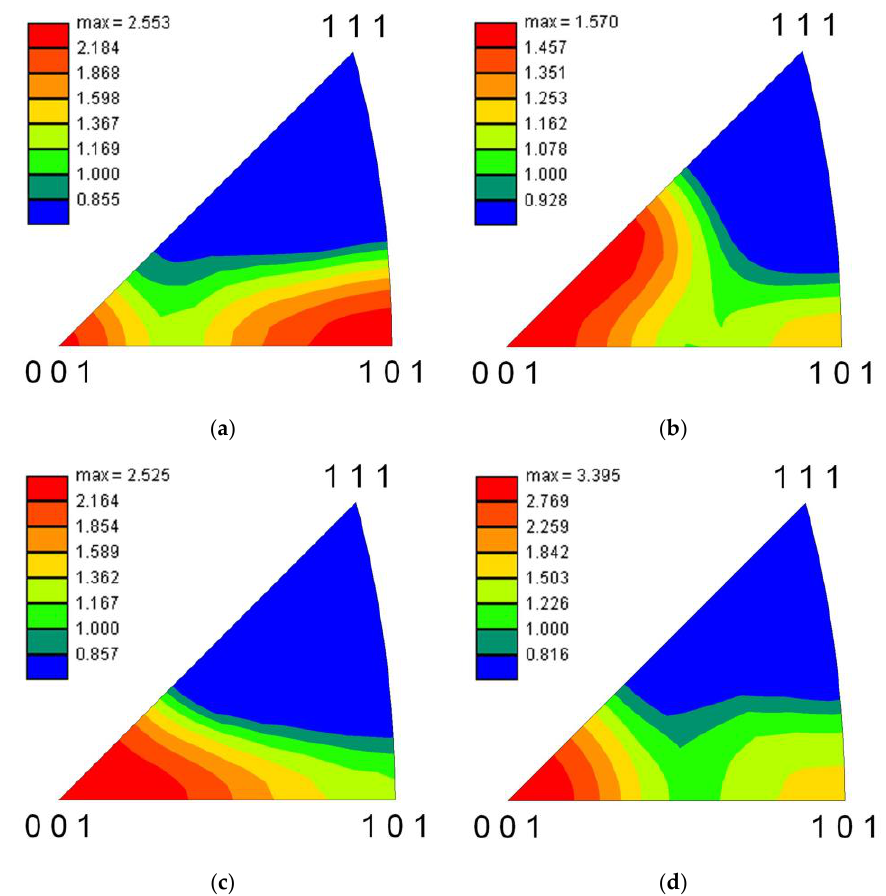
Figure 6. Inverse pole figures for a high-Mn steel subjected to hot compression at T = 1073 K and strain rate of 10 −2 s −1 ( a ); at 1073 K and 10 −3 s −1 ( b ); at 1223 K and 10 −2 s −1 ( c ); and at 1323 K and 10 −3 s −1 ( d ).